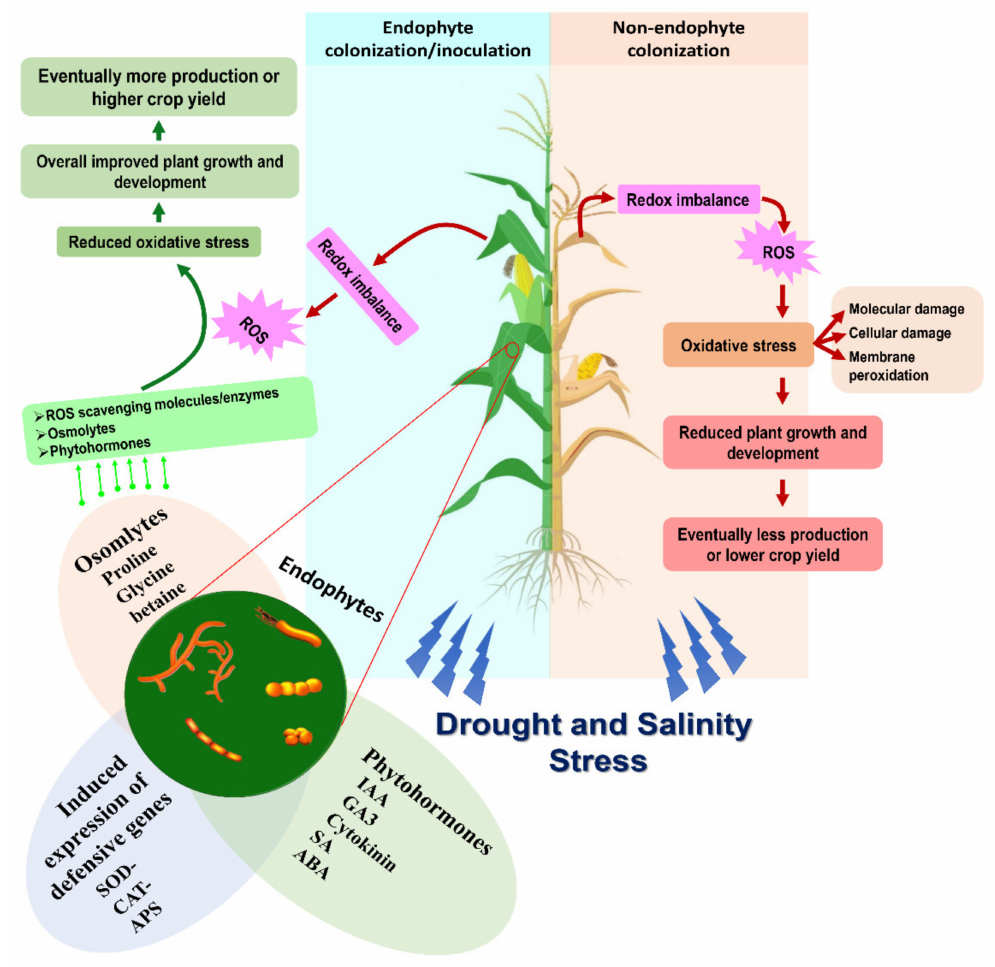
Figure 1. Overview of endophyte-mediated mechanisms for drought and salinity stress management in crop